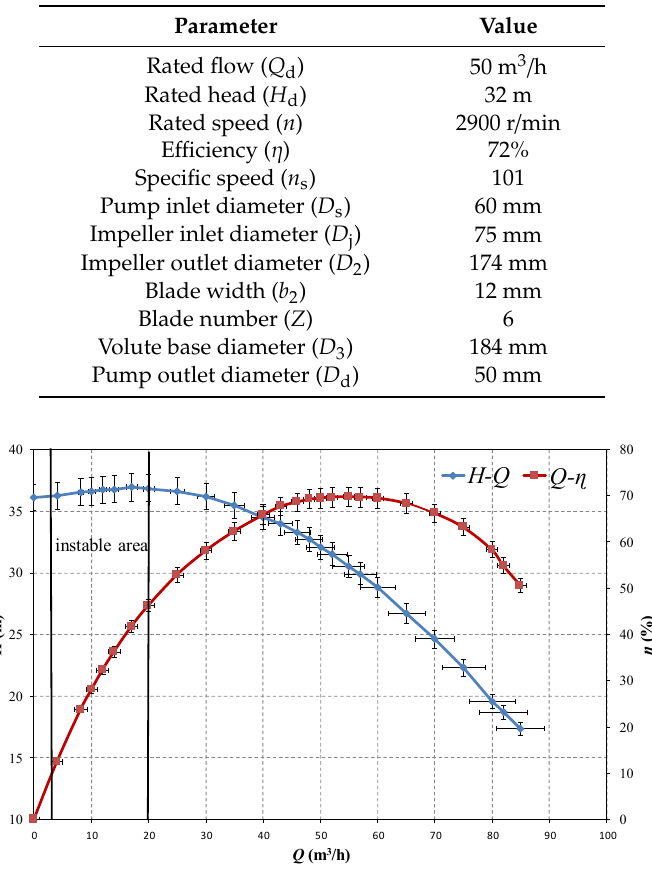
Figure 2. Pump performance curve.